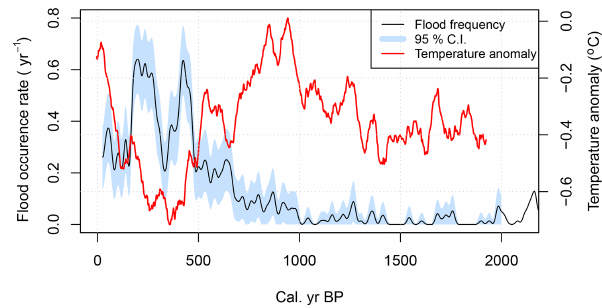
Figure 17. Flood frequency in Glomma (blue bars) and 30- year moving average Northern Hemisphere summer temperature anomaly from Moberg et al.